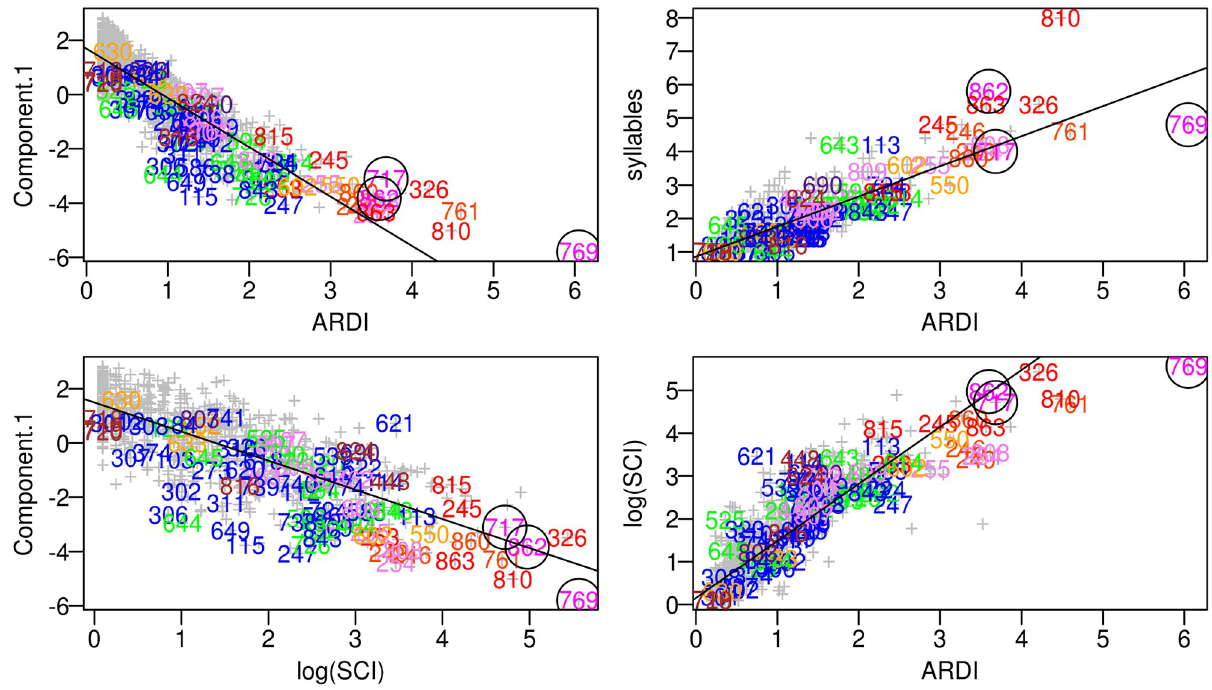
Fig 6. Scatter plots of ARDI versus various other possible metrics of acoustic musicality. Colors are coded the same as in Fig 3 (with warmer colors corresponding to more human music relevant names) and circles enclose each of the three primate songs: Indri indri ’s: “song” (#717), Tarsius spectrum ’s “duet song” (#769), and Hylobates leucogenys ’ “trio song” (#862). ARDI identifies fewer false positives � than both PC1 (e.g. trills and twitters) and syllable count (e.g. #643 twitter & #113 trill) whereas log(SCI) captured songs more efficiently � . SCI tends to reward longer, more repetitive calls such as the loud call (#448) of Macaca silenus , the duet of Lepilemur edwardsi (#815), the chirrup pumping (#46) of Callicebus moloch , or the pant-hoot- drum (#820) of Pan troglodytes . ARDI, alternatively, tends to boost scores of shorter, more transpositionally musical calls such as the gothic chucks (#648) of Saimiri sciureus , u-trills (#113) of Cebus olivaceus , the twitter (#726) of Tarsius syrichta , or the trill (#247) of Hylobates lar (see also Fig 1). Note that SCI is arbitrarily scaled, but conveniently happens to align well with the scales that manifest for syllable count and ARDI. ( � compared with researcher